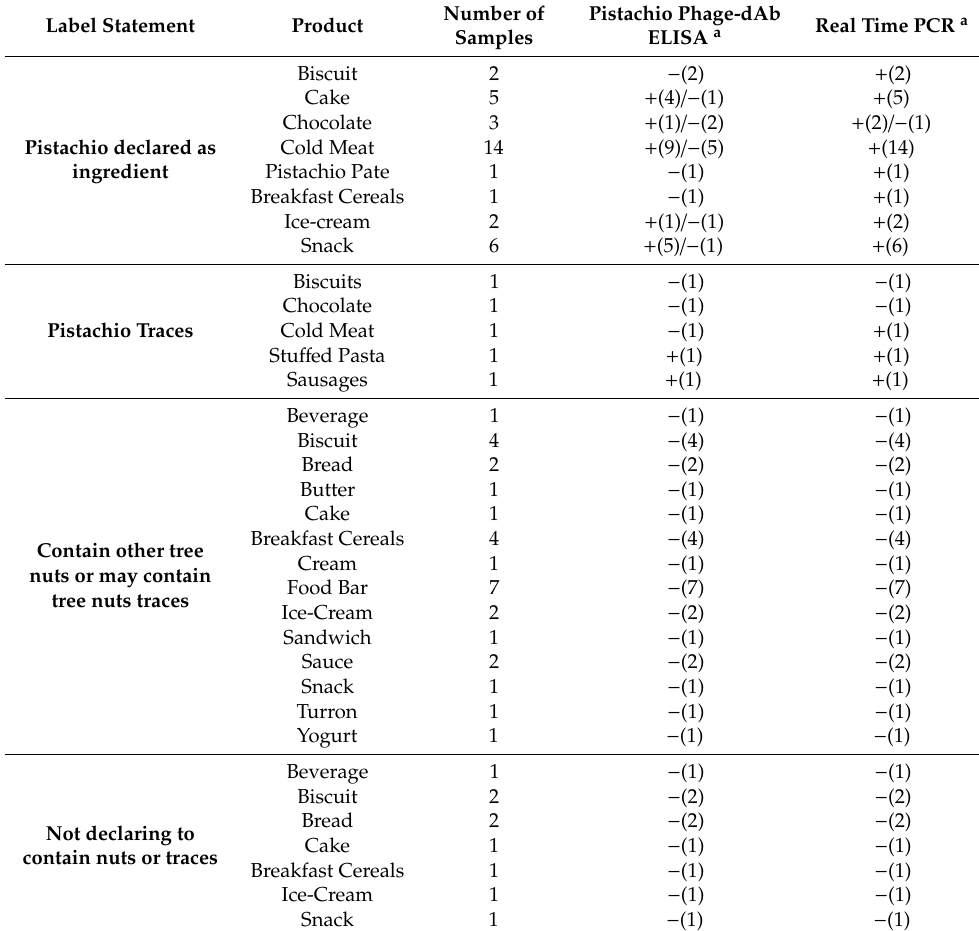
Table 3. Determination of the presence of pistachio in commercial processed food products using